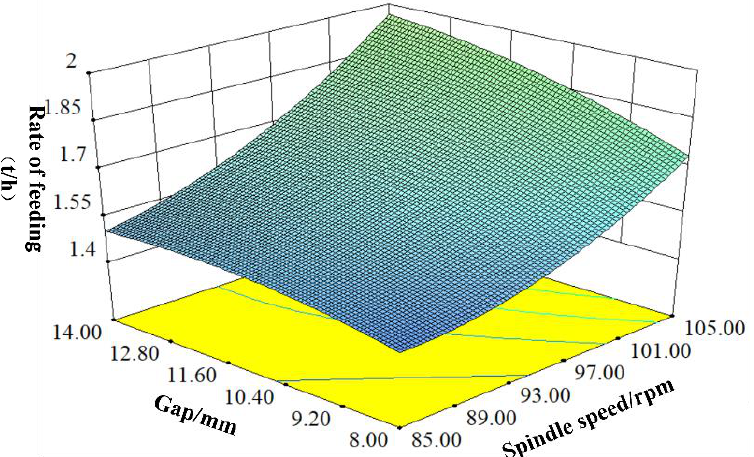
Figure 9. Influence of gap and spindle speed on feeding rate.